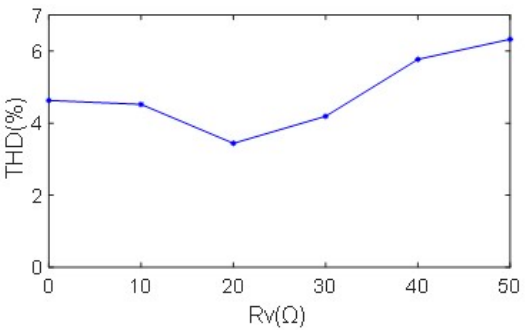
Figure 16. Relationship between THD and virtual impedance .